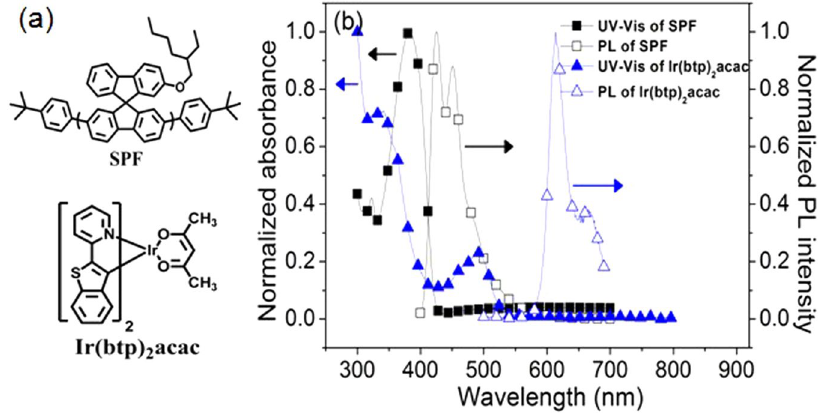
Figure 1. ( a ) Chemical structures of SPF and Ir(btp) 2 acac. ( b ) UV-Vis absorption and PL spectrum of SPF as thin solid film and those of Ir(btp) 2 acac in tetrahydrofuran